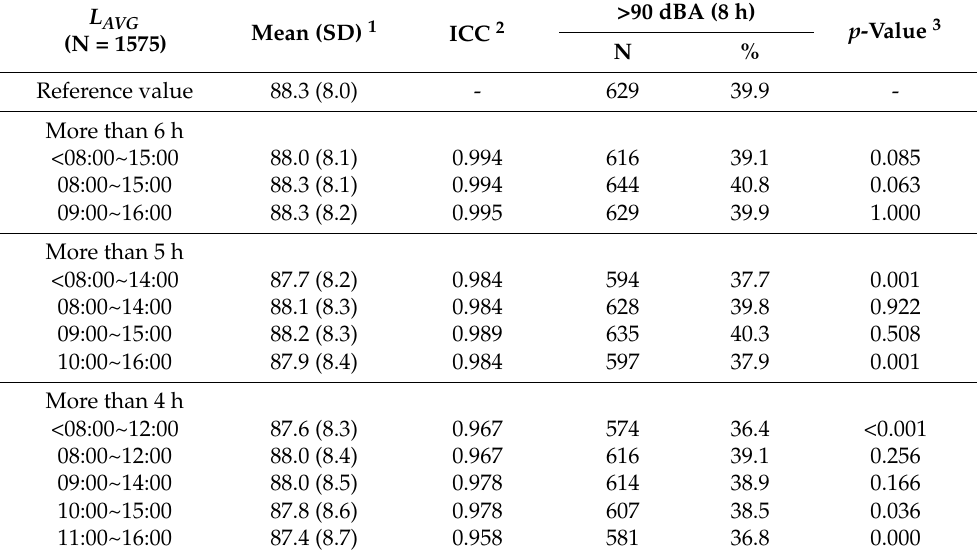
Table 7. The mean levels of occupational noise exposure compared with an exposure limit of 90 dBA (8 h), excluding break period, by increasing an hour in different monitoring schedules.